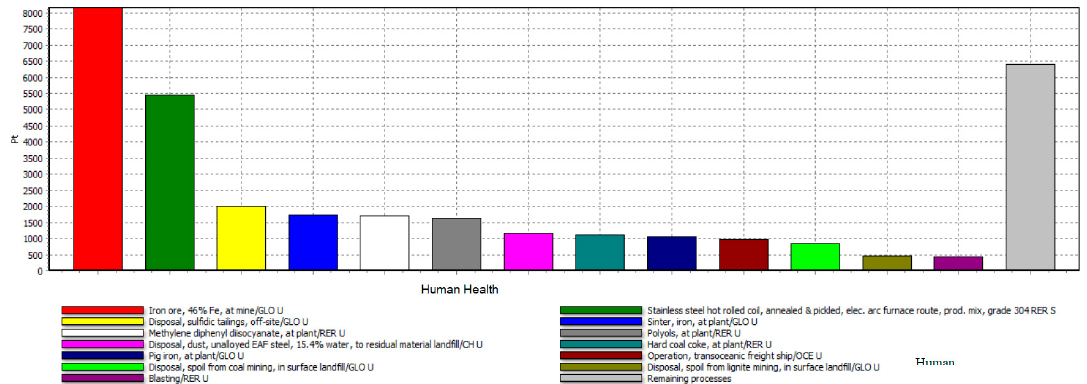
Figure 6. Comparison of major environmental impacts, related to the steel structure of the office building, on the human health damage category.